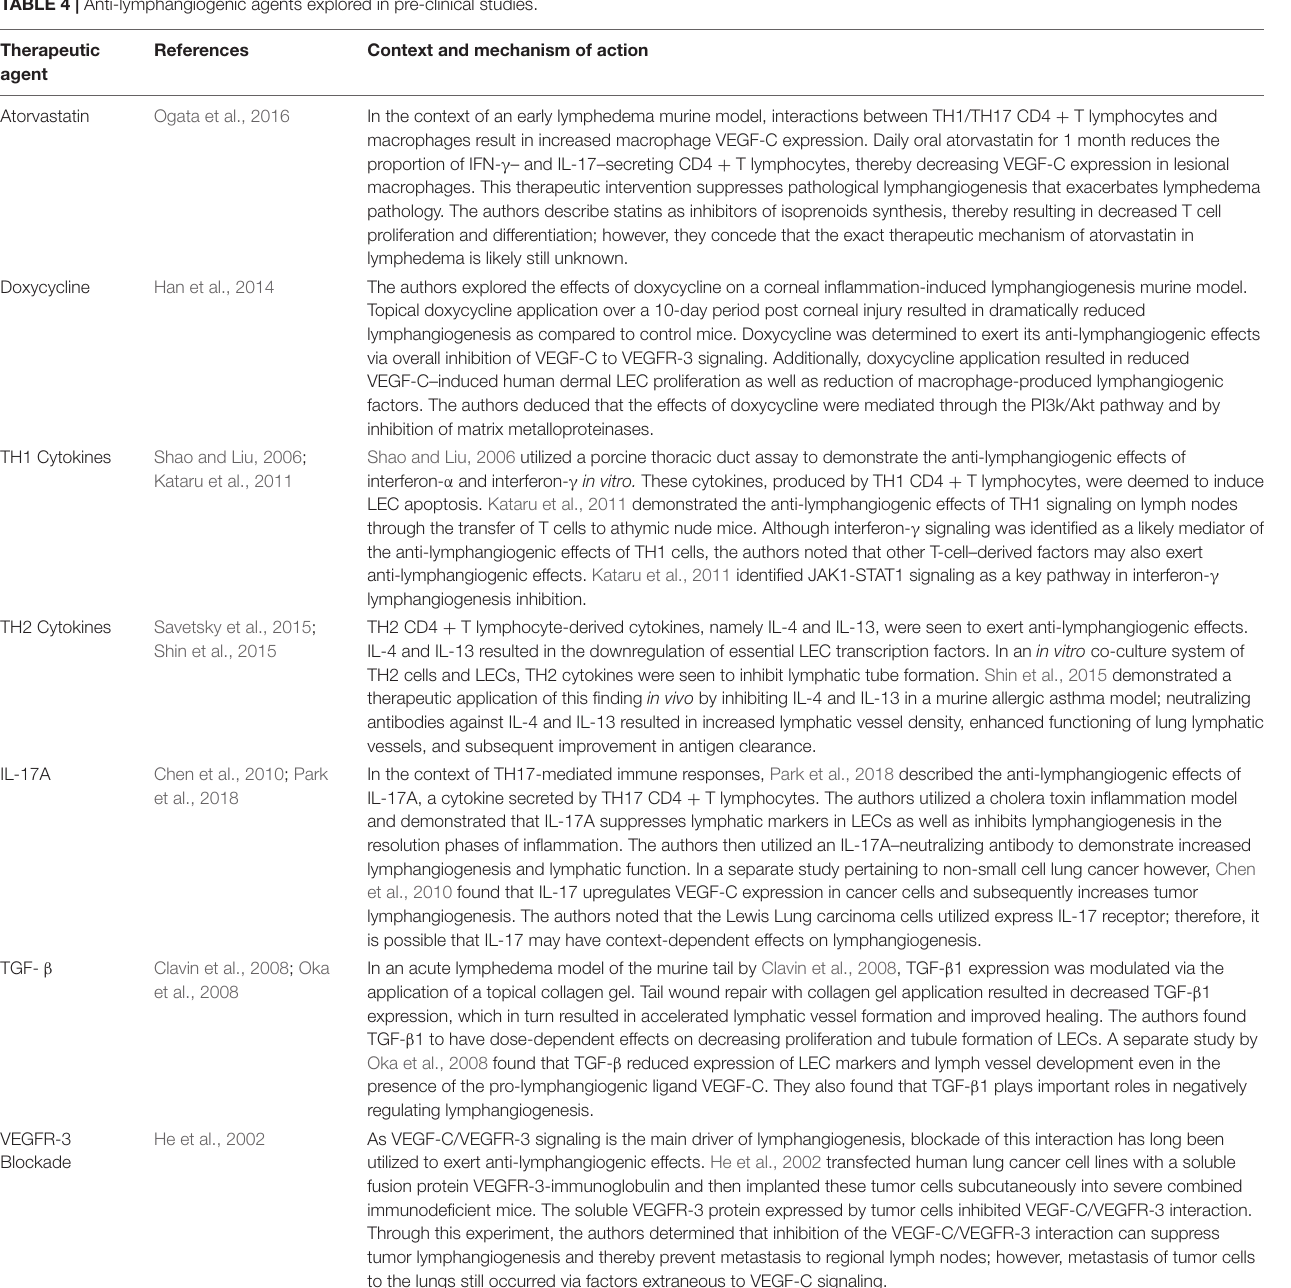
TABLE 4 | Anti-lymphangiogenic agents explored in pre-clinical